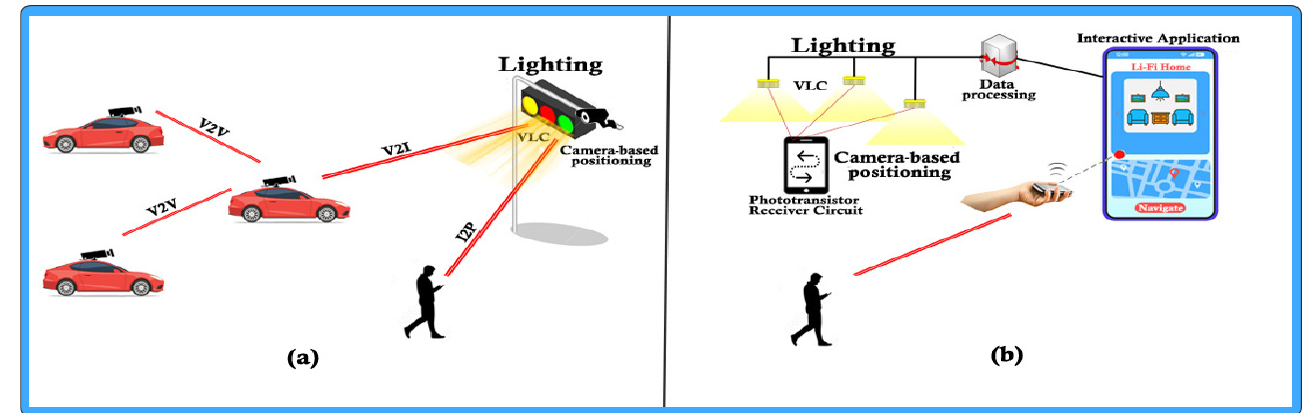
Figure 2. ( a ) The main scheme of V2I communications (vehicle-to-infrastructure) and ( b ) represent visible light communications based on optical camera communication and environmental sensors.